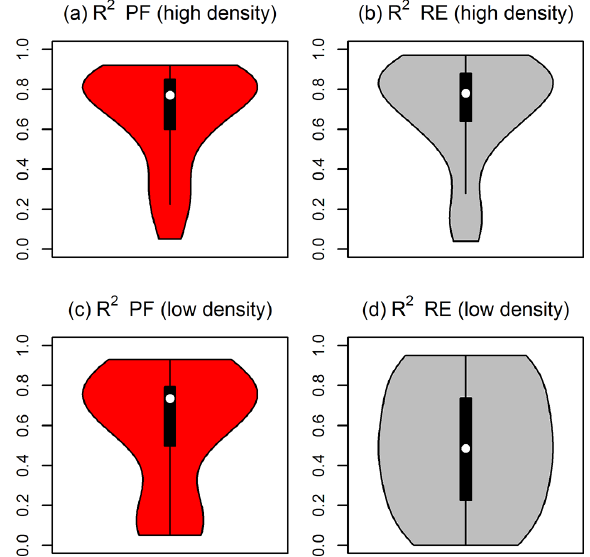
Figure 10. Distribution of event- R 2 for CDP events for the PF (a, c) and RE (b, d) model. The sample is split into initial bulk snow densities above 350kgm − 3 (a, b) and below 350kgm − 3 (c, d)